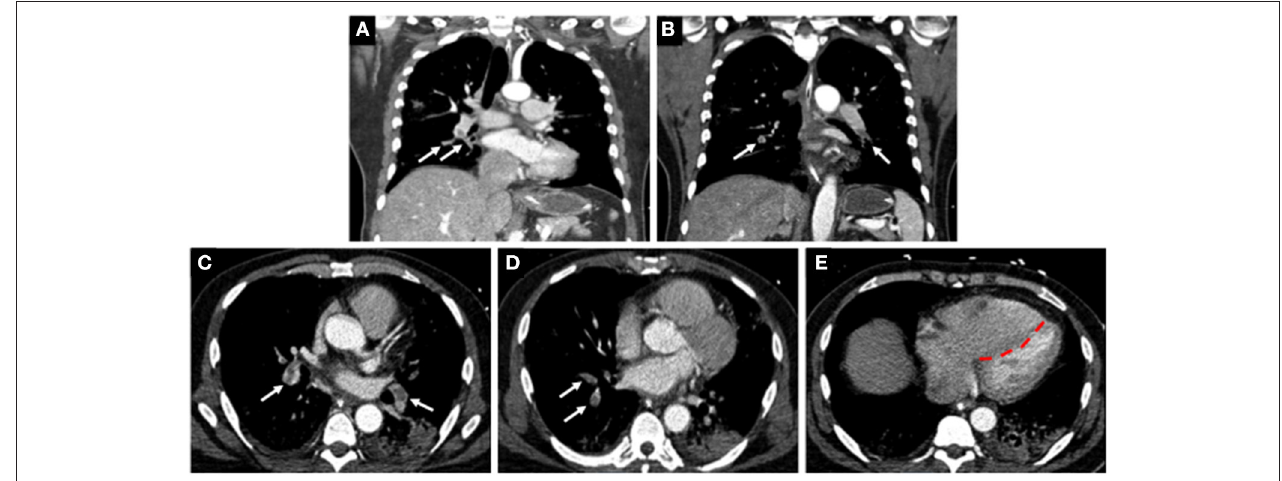
FIGURE 4 | Computed tomographic (CT) images of a COVID-19 positive patient who presented with bilateral lobar pulmonary embolism (white arrows; A–D ), and right ventricular enlargement and bowing of the interventricular septum to the left, consistent with right heart strain (red line; E ).